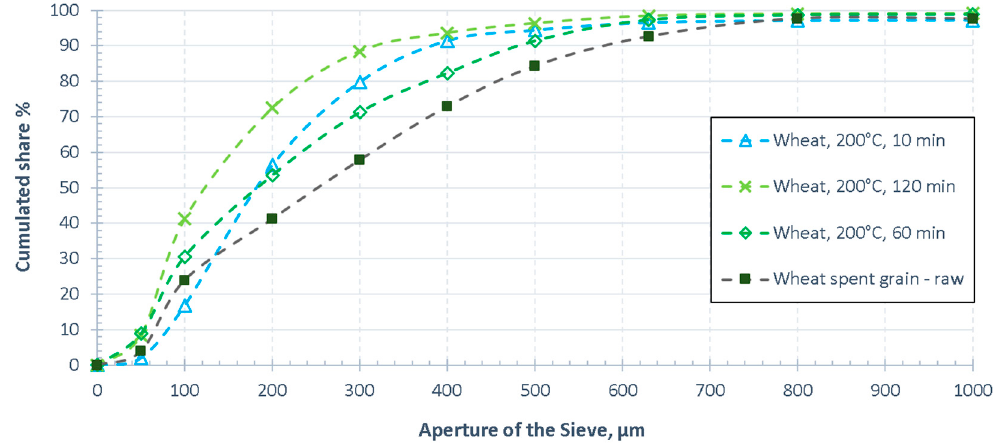
Figure 13. Particle size distribution after grinding spent grain from wheat-based beer and respective hydrochars in Retsch SM100 knife mill.